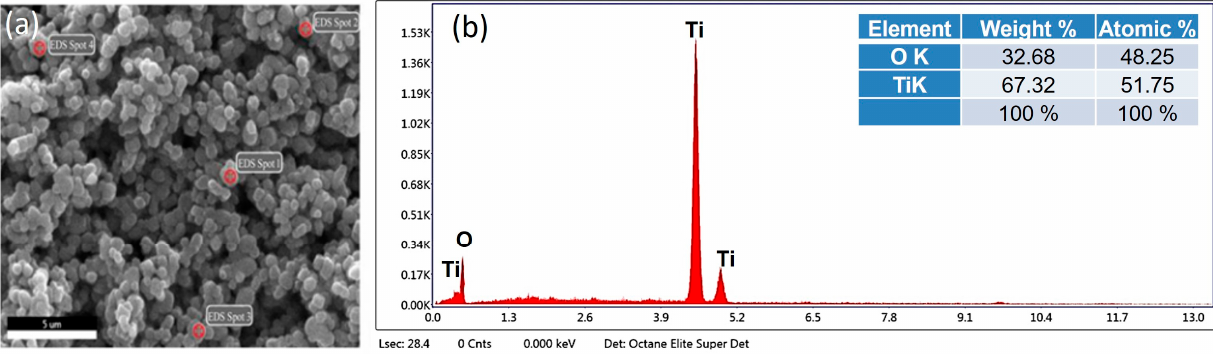
Figure 6. Energy dispersive X-ray spectroscopic analysis of TiO 2 nanoparticles displaying the ( a ) SEM image with EDX Spots. ( b ) Elemental composition showing peaks of titanium and oxygen.